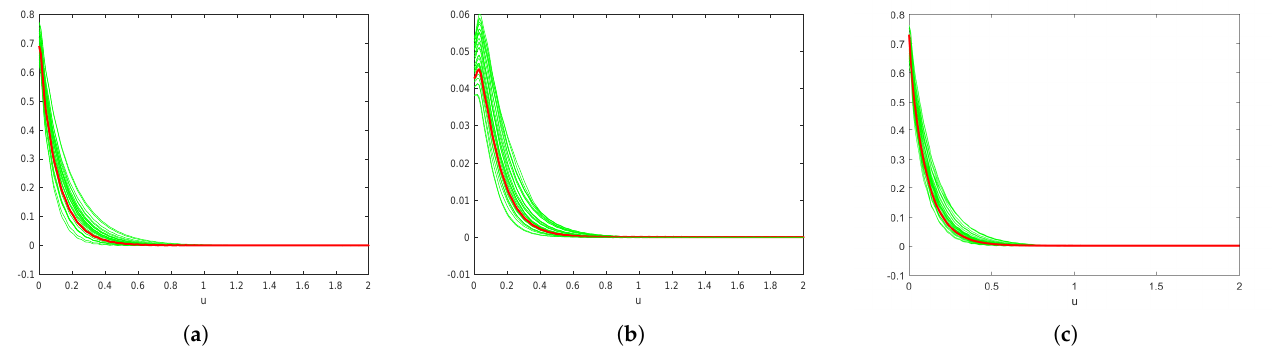
Figure 3. For the Lévy-Gamma risk model, we estimate the Gerber–Shiu functions by true value curves (red curves) and 25 estimated value curves (green curves). ( a ) Ruin probability; ( b ) Expected claim size causing ruin; ( c ) Laplace transform of ruin time.